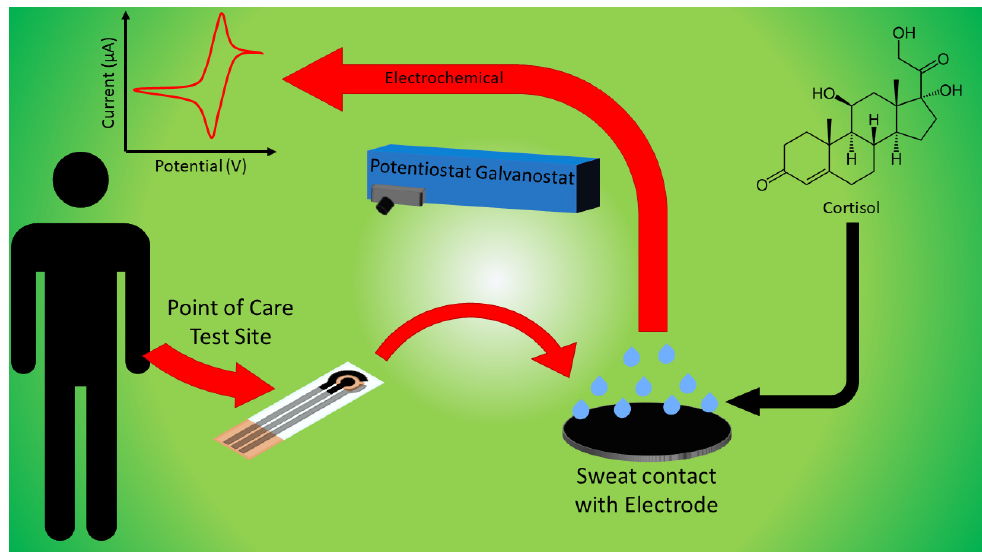
Figure 1. A conceptual graphical abstract of the functionality of the graphene oxide-based biosensor in detecting sweat cortisol for diagnostic purposes.